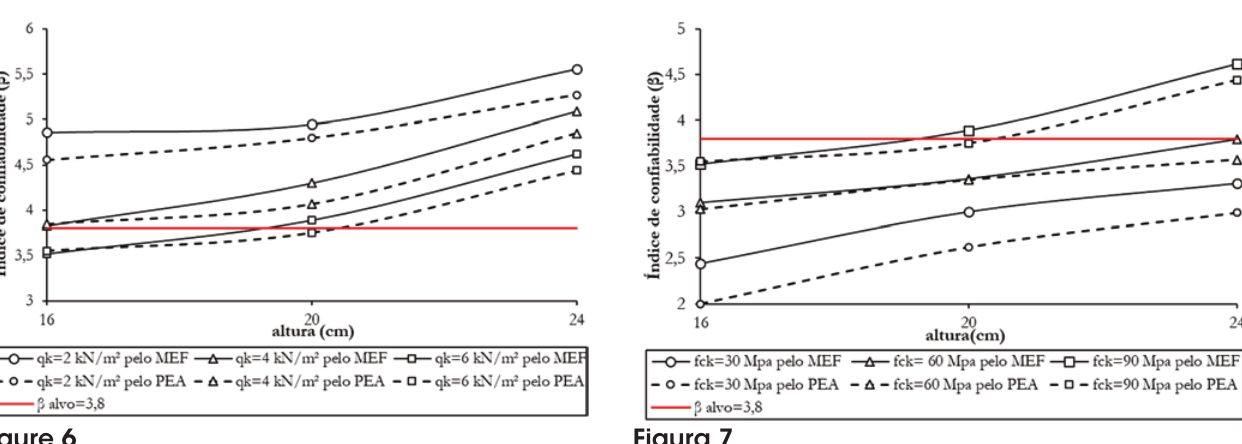
Análise do índice de confiabilidade para as lajes com carregamento acidental de 6 kN/m²